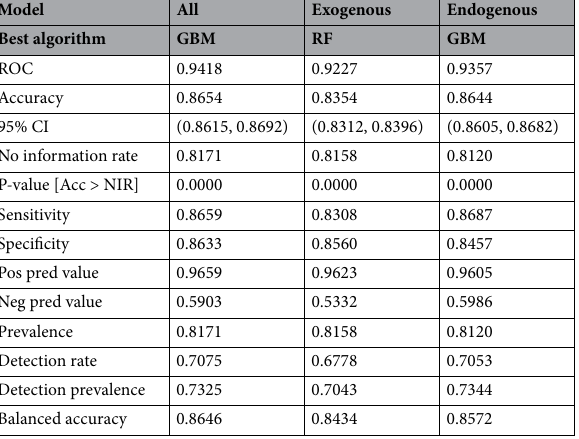
Table 6. Accuracy performance indicators for European universities’ co-publication prediction in Multidisciplinary Science. Three models considered: with all, with only exogenous, and with only endogenous features.